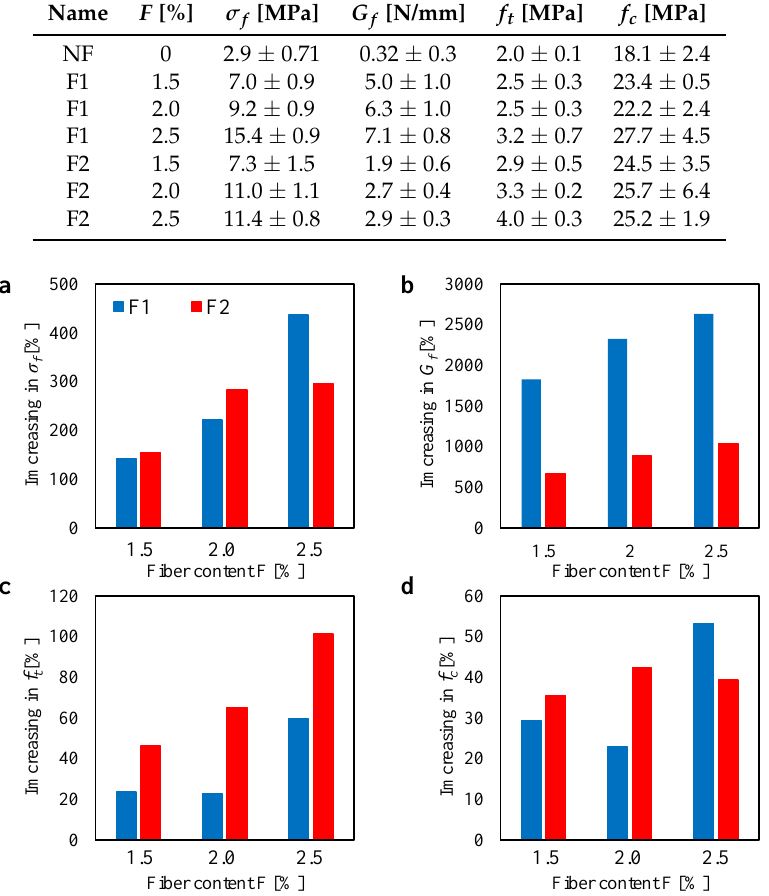
Figure 12. Increase in the mechanical properties (flexural strength σ f , fracture energy G f , tensile strength f t and compressive strength f c ) with respect to the unreinforced case by varying the fiber content. Figure also shows the comparison between the two fiber types (the F1 and the